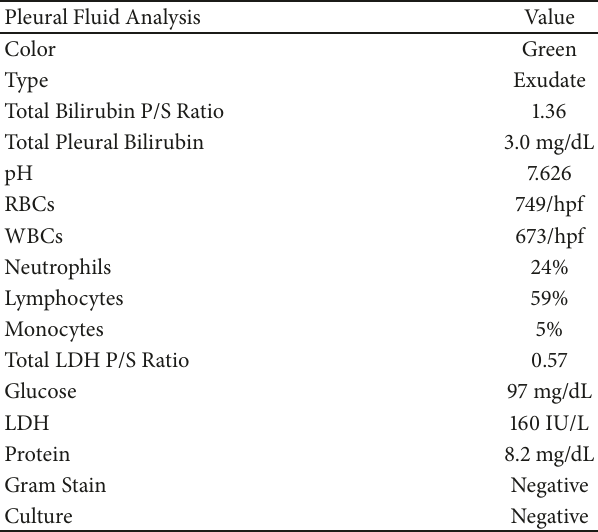
Table 1: Pleural fluid analysis